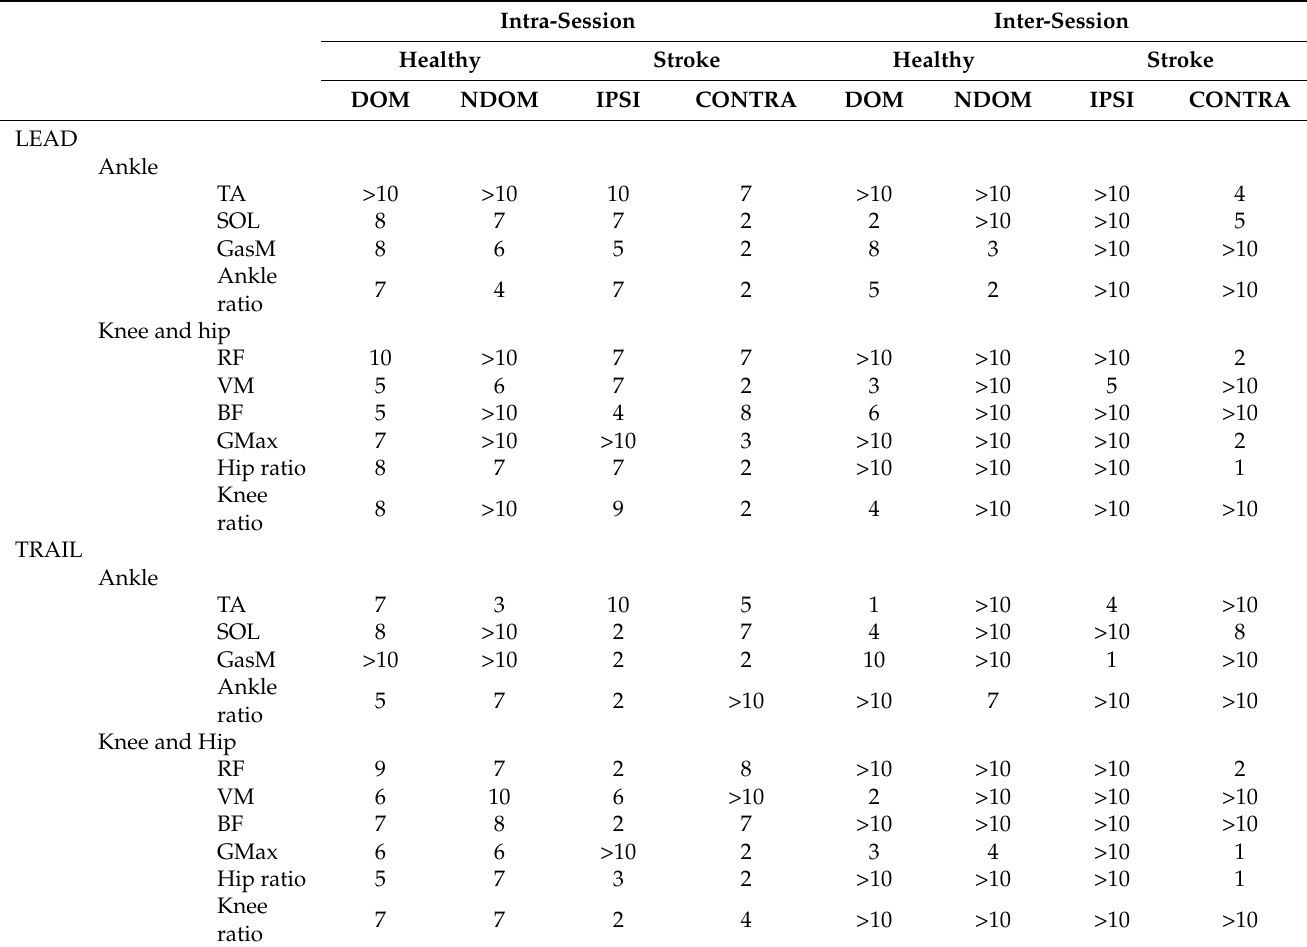
Table 4. Number of trials needed to reach good performance stability intra-session and inter-session (ICC > 0.75) of the electromyographic activity of muscles, tibialis anterior (TA), soleus (SOL), gas- trocnemius medialis (GasM), rectus femoris (RF), biceps femoris (BF), vastus medialis (VM), and gluteus maximus (GMax) and the hip, knee, and ankle coactivation ratio with the dominant lower limb (healthy)/ipsilesional (STROKE) in the positions of TRAIL and